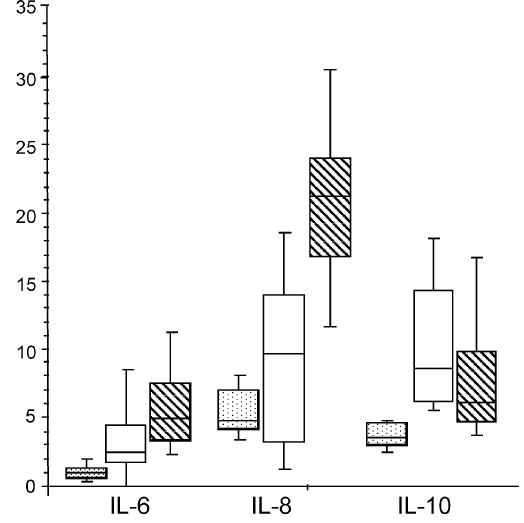
FIG. 2. Circulating cytokine levels in vasculitis patients in stable phase, separated according to subsequent develop- ment of severe organ damage during the follow-up period. , results from 17 patients who did develop organ damage during the follow-up period; , results from 38 patients were no adverse event was observed (for 77 IL-6 patients); , healthy control group.